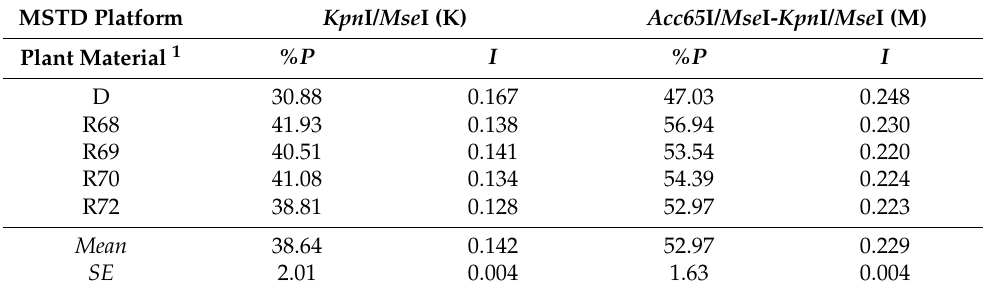
Table 1. Percentage of polymorphic loci ( %P ) and Shannon’s information index ( I ) for MSTD data amplified from plant